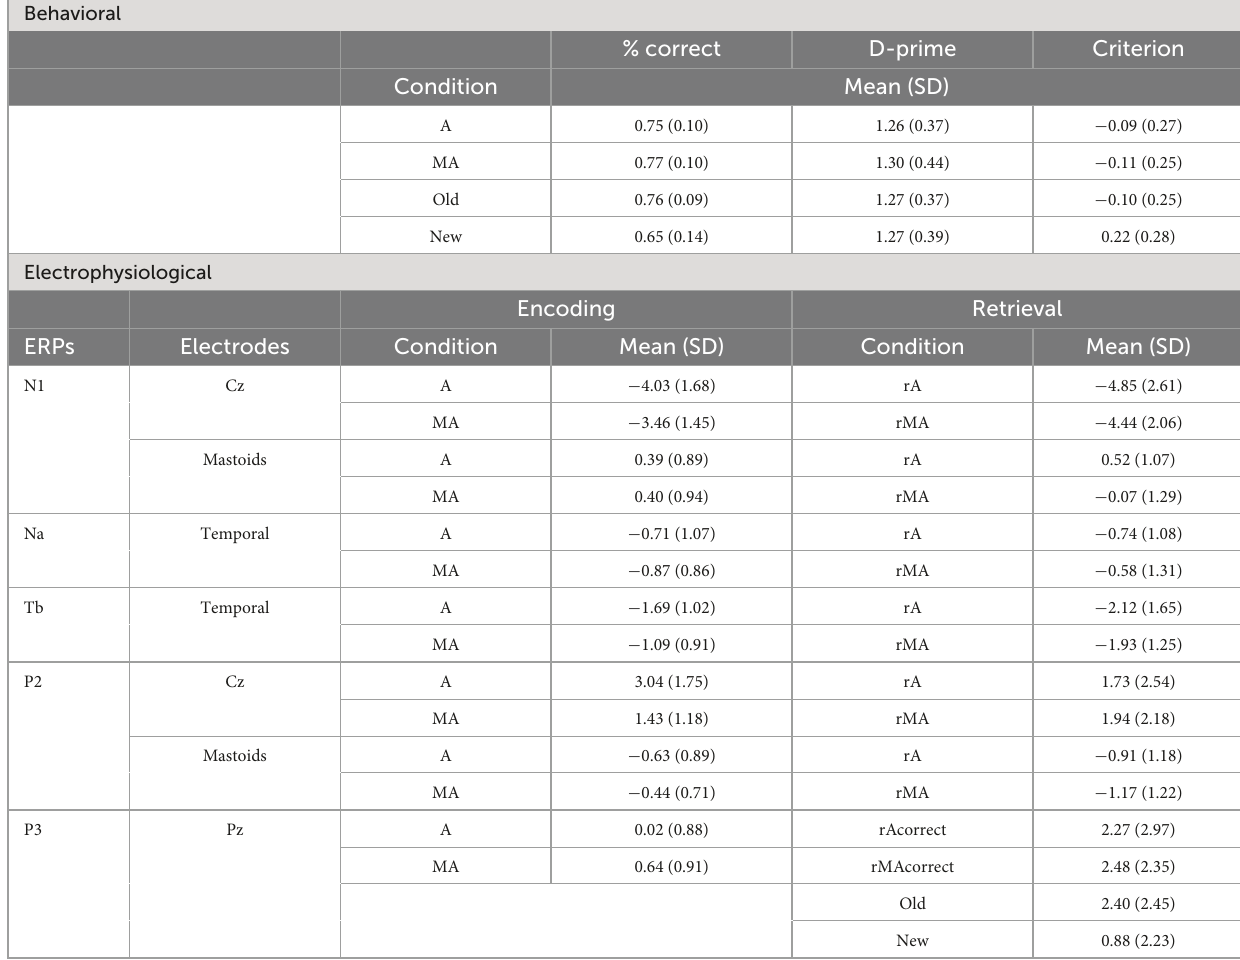
TABLE 1 Mean amplitudes and standard deviations of the